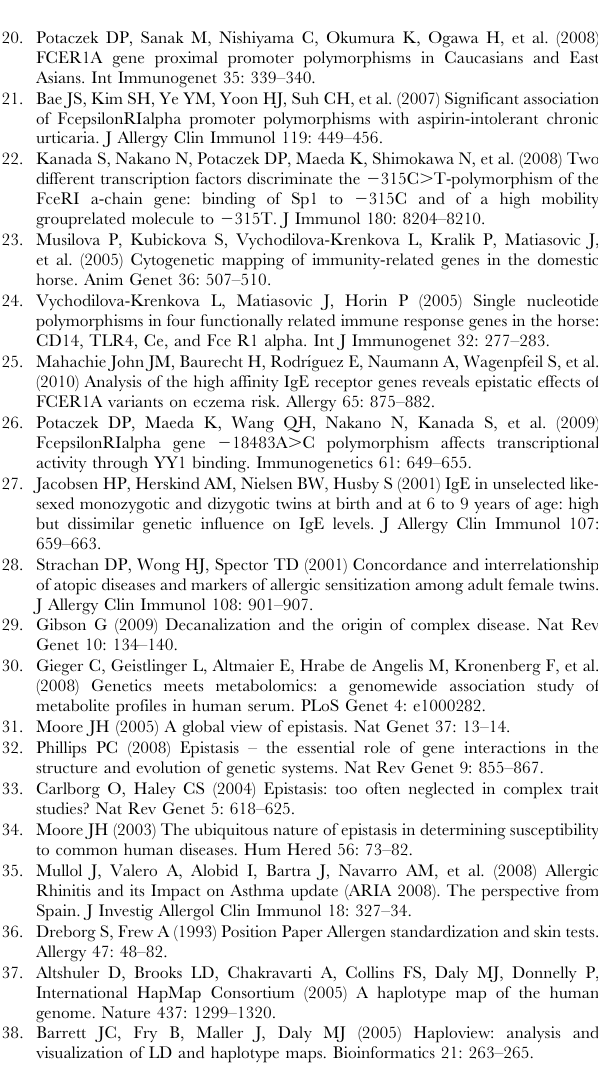
Table S1 Allergen-specific association analyses of SNPs in FCER1A and AR .